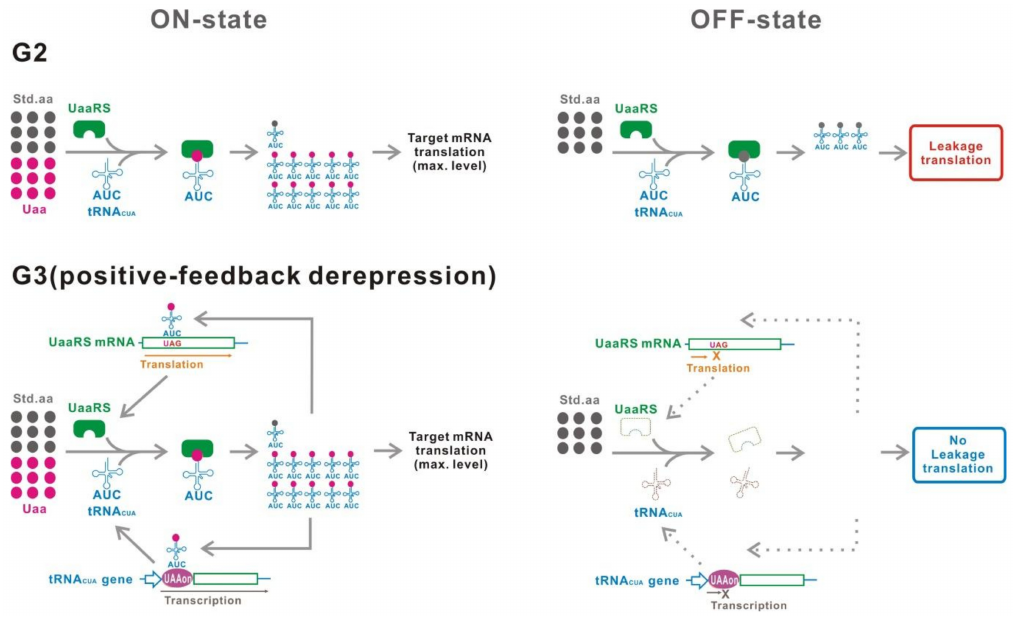
Figure 6. Tight G3 translational switch using a positive-feedback derepression gene circuit. In G2, the UaaRS and tRNA CUA are expressed even in the OFF-state, causing a significant level of leakage translation. A positive-feedback derepression circuit from the Uaa-tRNA CUA to the UaaRS and/or tRNA CUA gene decreases the expression level of those genes in the OFF-state, resulting in a suppression of leakage